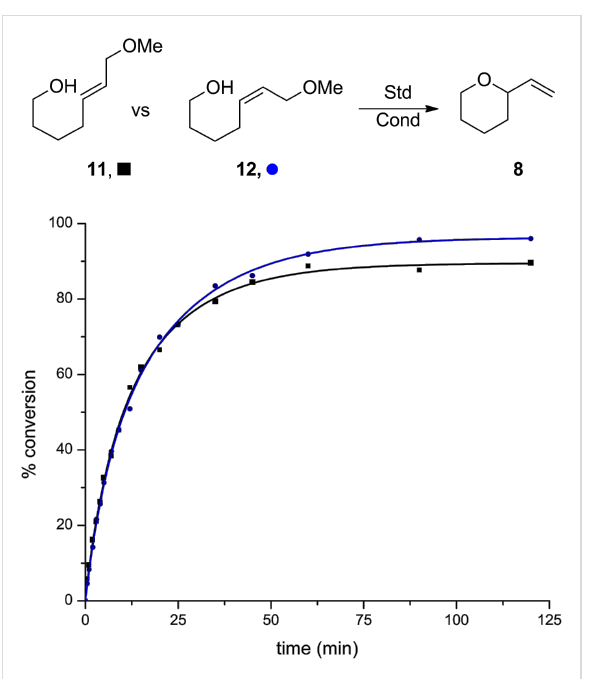
Figure 4: Reaction progress in cis - and trans -methyl ethers. Condi- tions: 5 mol % Au[P( t -Bu) 2 ( o -biphenyl)]SbF 6 , CH 2 Cl 2 , MS 4 Å.